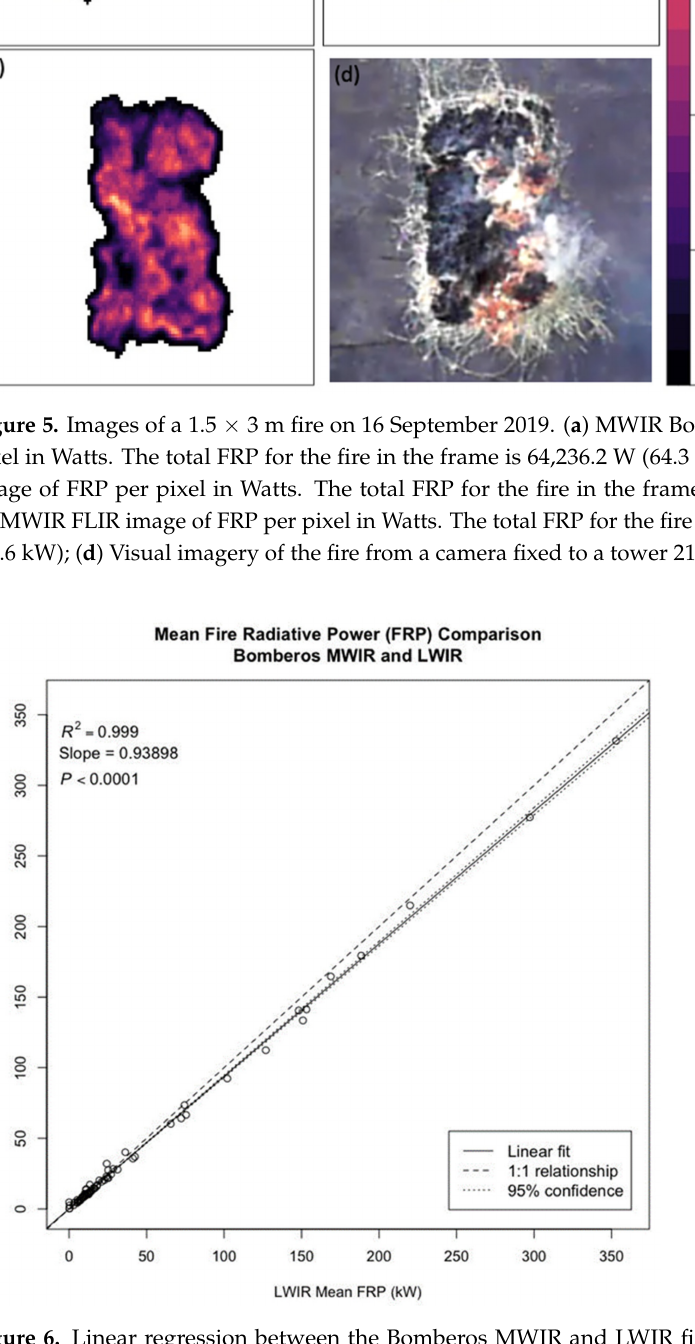
Figure 6. Linear regression between the Bomberos MWIR and LWIR fire radiative power (FRP). Data points consist of 67 different one-second sequences recorded from experimental fires conducted between 16 and 18 September